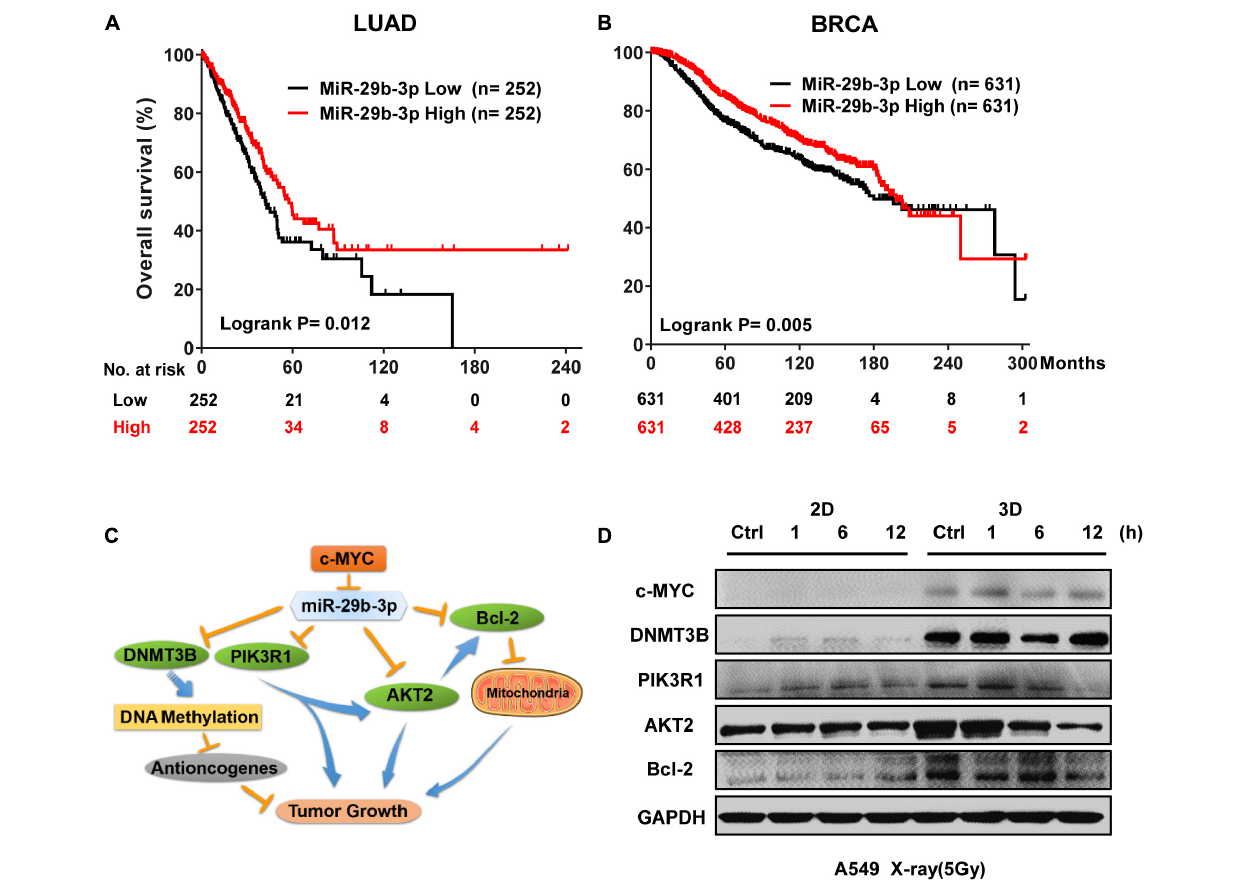
FIGURE 2 | MiR-29b-3p expression affects survival probability in LUAD and BRCA by regulating oncogenes. (A) Kaplan–Meier survival curves of LUAD patients with low or high miR-29b-3p expression. (B) Kaplan–Meier survival curves of BRCA patients with low or high miR-29b-3p expression. (C) A schematic representation showing the signaling pathway of miR-29b-3p suppressing tumor growth by targeting a series of oncogenes. (D) Western blot assay on the expression of c-MYC, DNMT3B, PIK3R1, AKT2 and Bcl-2 at the indicated time points after 5 Gy X-rays in 2D and 3D cultured A549 cells. Ctrl, unirradiated groups. The cut-off values of high and low are median in LUAD and BRCA. P -values calculated by use of logrank